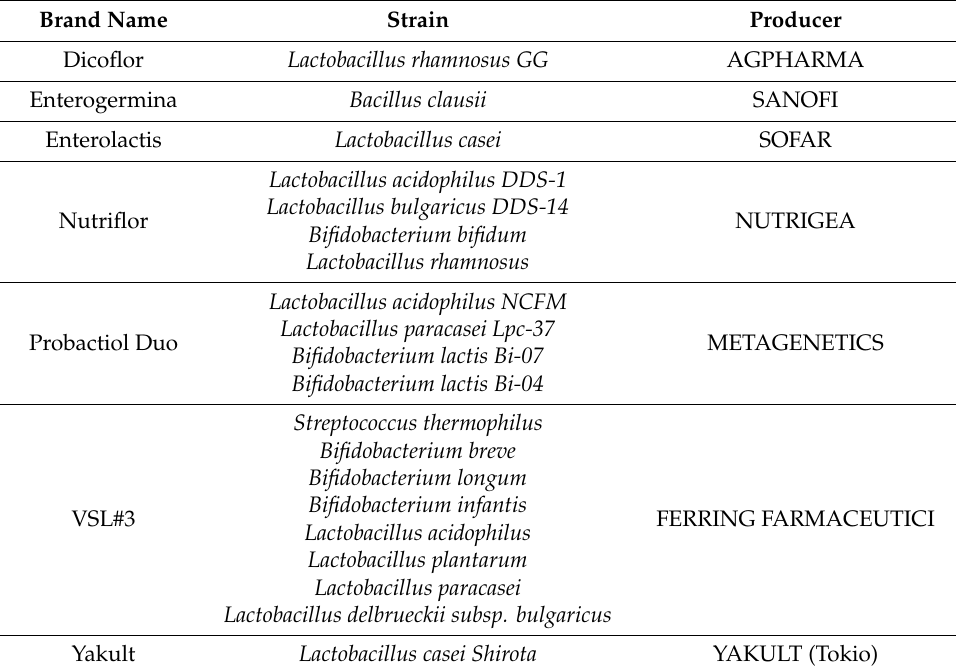
Table 2. Examples of some commercially available